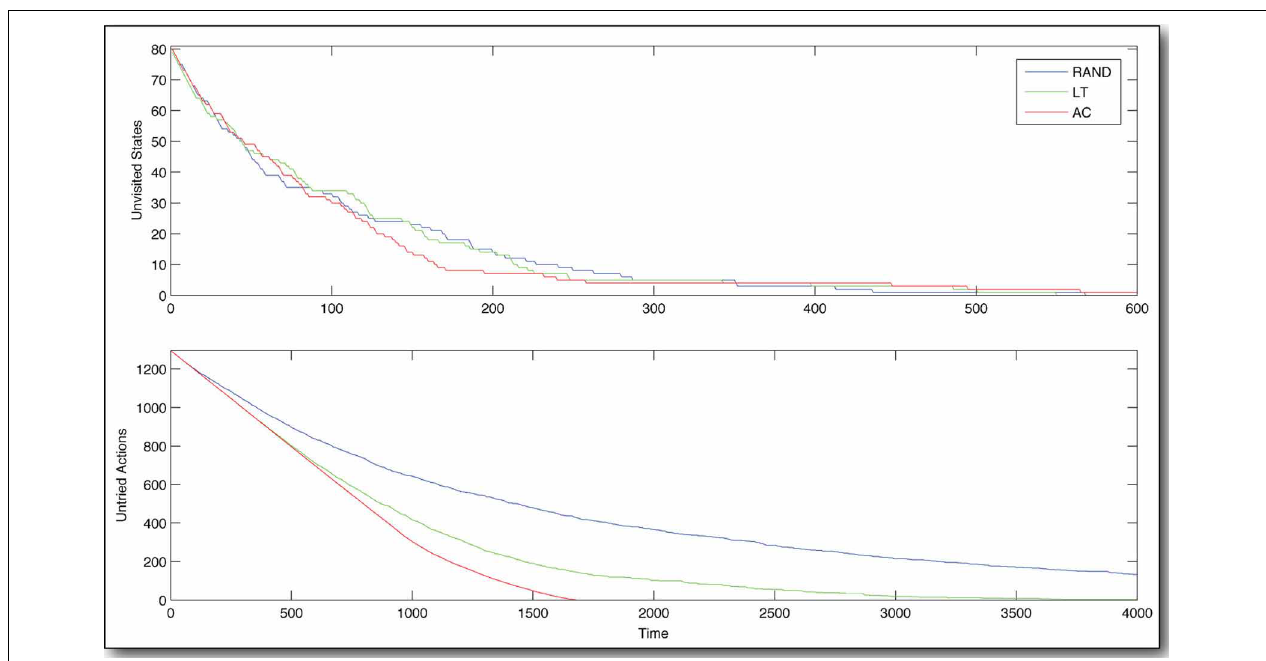
FIGURE 4 | State-action space coverage during early learning. The policy based on Artificial Curiosity (AC) explores the state-action space most efficiently, compared to policies based on random exploration (RAND) and always selecting the least tried state-action (LT). Time is measured in state transitions.